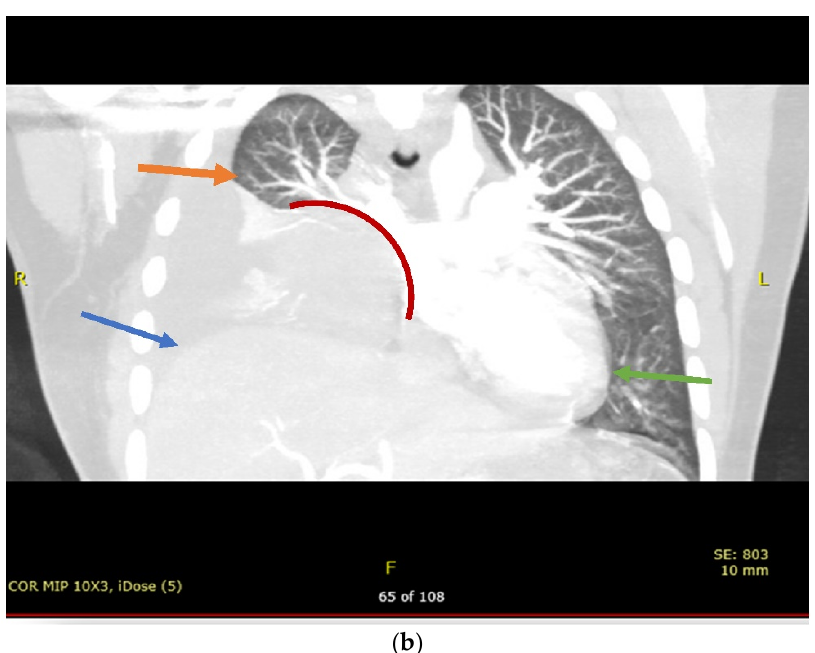
Figure 1. ( a ) Axial view of chest CTA showing mediastinal mass (blue arrows) compressing the right atria and ventricle along with right lung atelectasis and cardiac displacement to the left. Right sided pleural effusion (yellow arrow) can also be appreciated in the image. ( b ) Coronal view of chest CTA showing mediastinal mass compressing the right atria and right ventricle (red margin) along with right lung atelectasis (yellow arrow) and cardiac displacement to the left (green arrow). Right sided pleural effusion (blue arrow) can also be appreciated in the image.